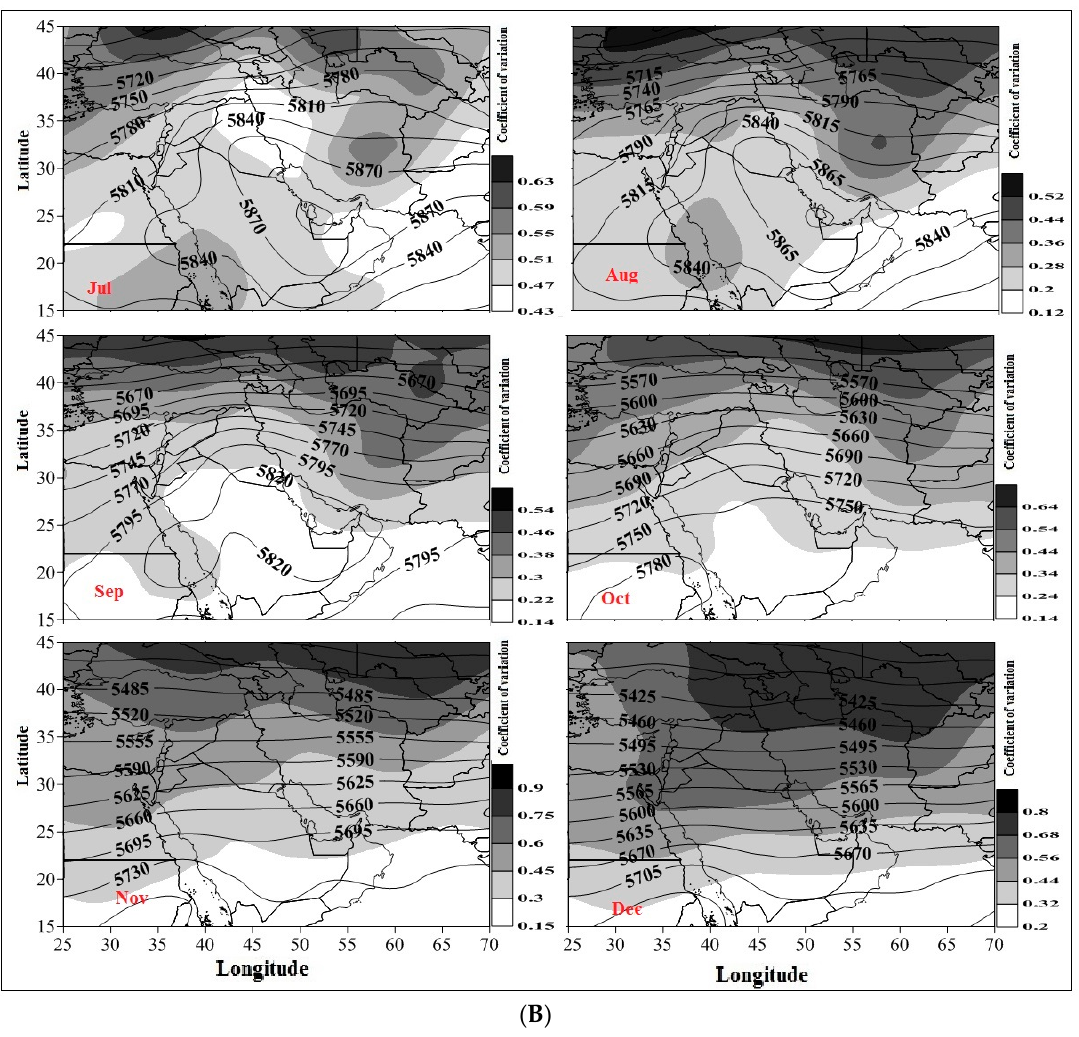
Figure 2. ( A ) Spatial distribution of average of coefficient of variation of AT in each month in Iran and the Middle East; ( B ) Spatial distribution of average of coefficient of variation of AT in each month in Iran and the Middle East.